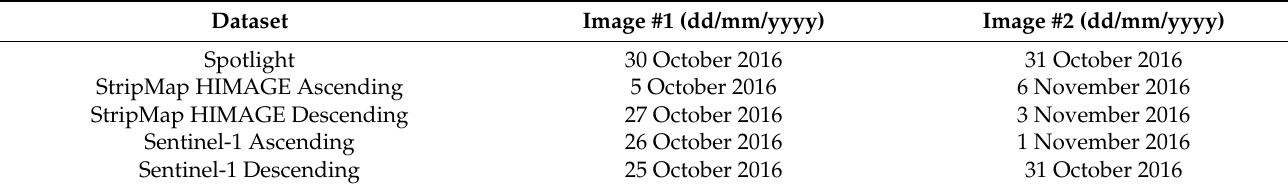
Table 3. RGB combination used for each stack for the